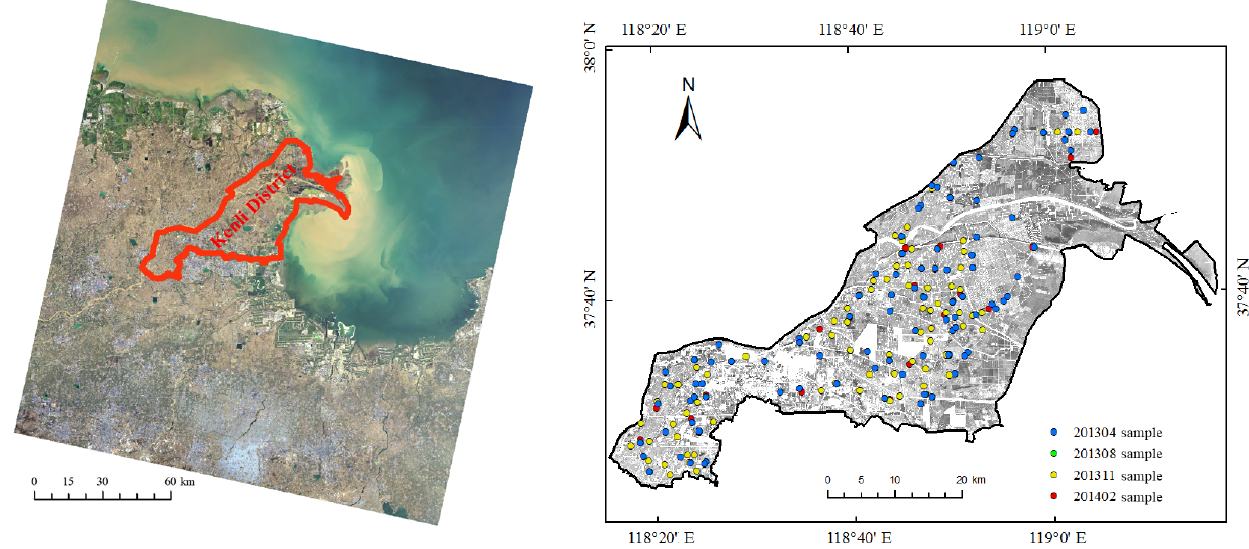
Figure 1. Location of the study area and sampling points. The data sources were Landsat images taken on 6 November 2013 from the © United States Geological Survey, https://earthexplorer.usgs.gov/ (last access: July 2019).